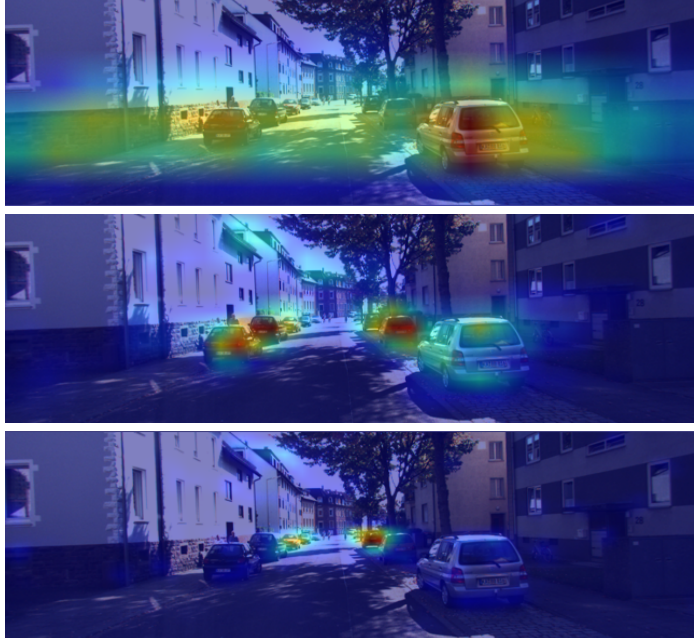
Figure 7. We apply the proposed Grad-CAM method to a vision object detection network with a multi-scale output grid. From top to bottom there is large, medium and small scale output CAM visualization for a car class. Results show distinct distances of detected objects from camera sensor at different scales. Combining CAMs and known labels, we can assign detection ranges for each output to better understand the